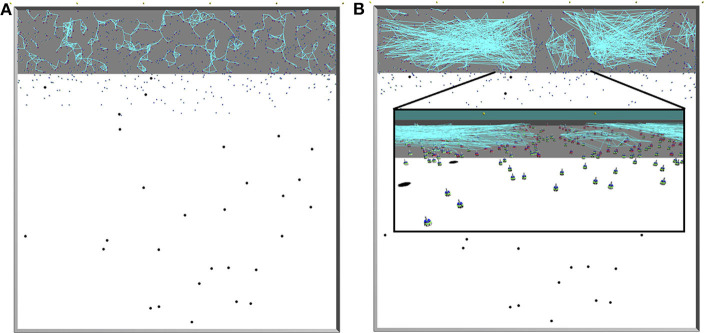
Illustrations of the arena taken from ARGoS simulations. Gray area: nest; white area: foraging environment; black dots: items; blue objects: Footbots; light-blue lines: communication (range-and-bearing) links. Top views onto the entire arena; the communication network is constructed in (A) using spatial network given by the local robot interactions, and in (B) using Algorithm 1; the inset shows a close-up view on the robots. In all figures, the communication links are formed only for resting robots inside the nest, as in our experiments moving robots neither broadcast nor listen to any messages.Therefore, it can happen that although a robot is within the communication range of another, no communication link is established between the two.